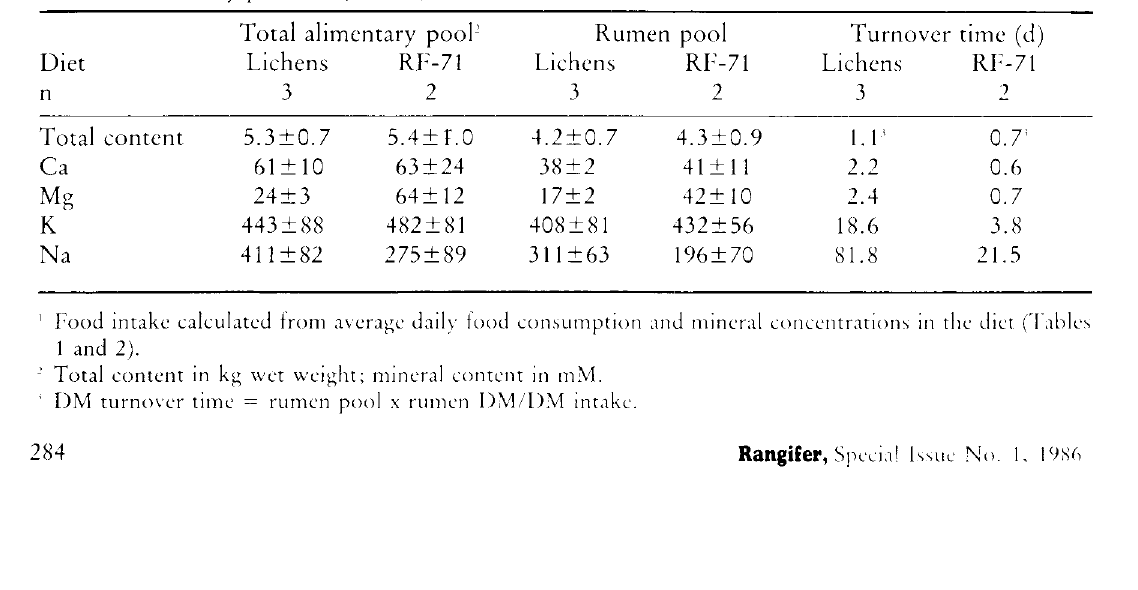
Table 5. Alimentary pool size (x±S.E.) and rumen mineral turnover time 1